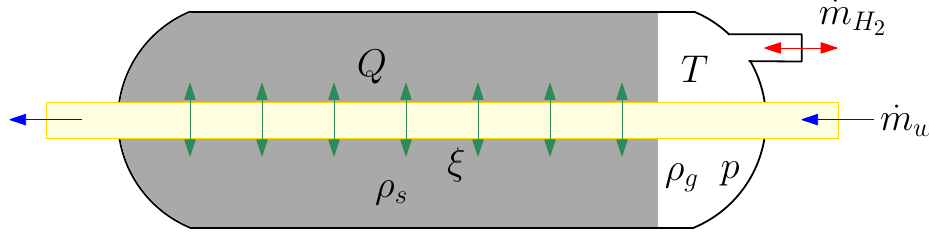
Figure 1. Synoptic